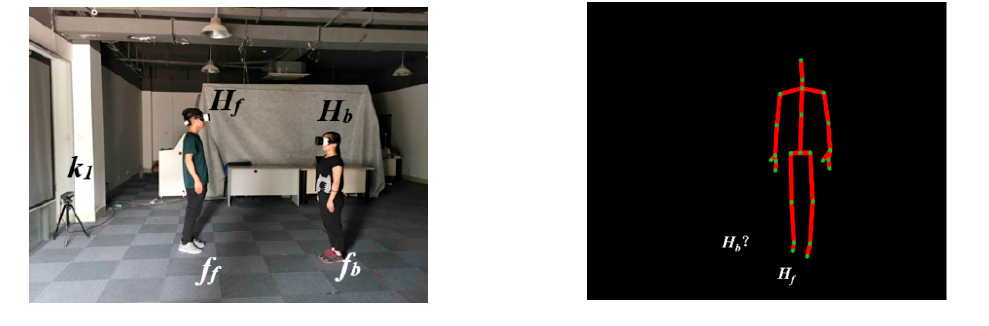
Figure 1. An example of an occlusion event.